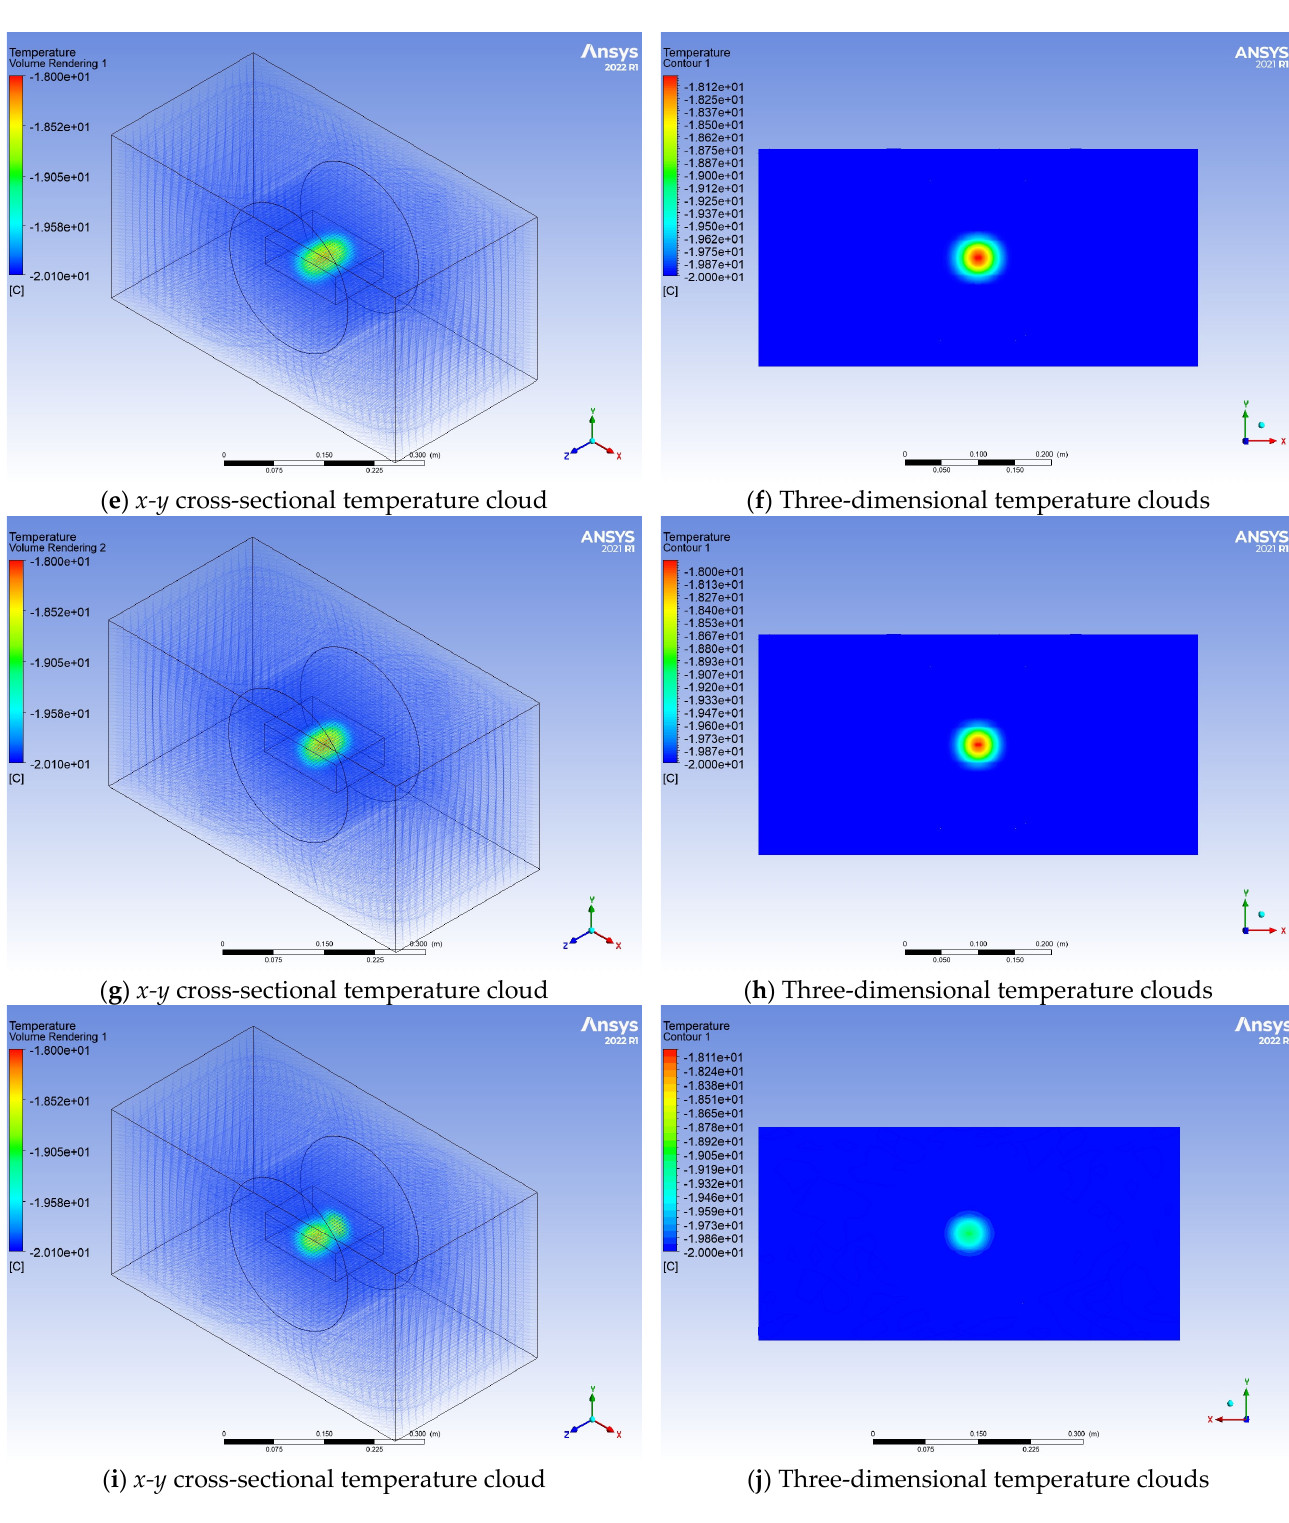
Figure 13. Temperature field program and x ‐ y section temperature program under different flow rates of refrigerant and different rotating speeds of the rotating hopper.